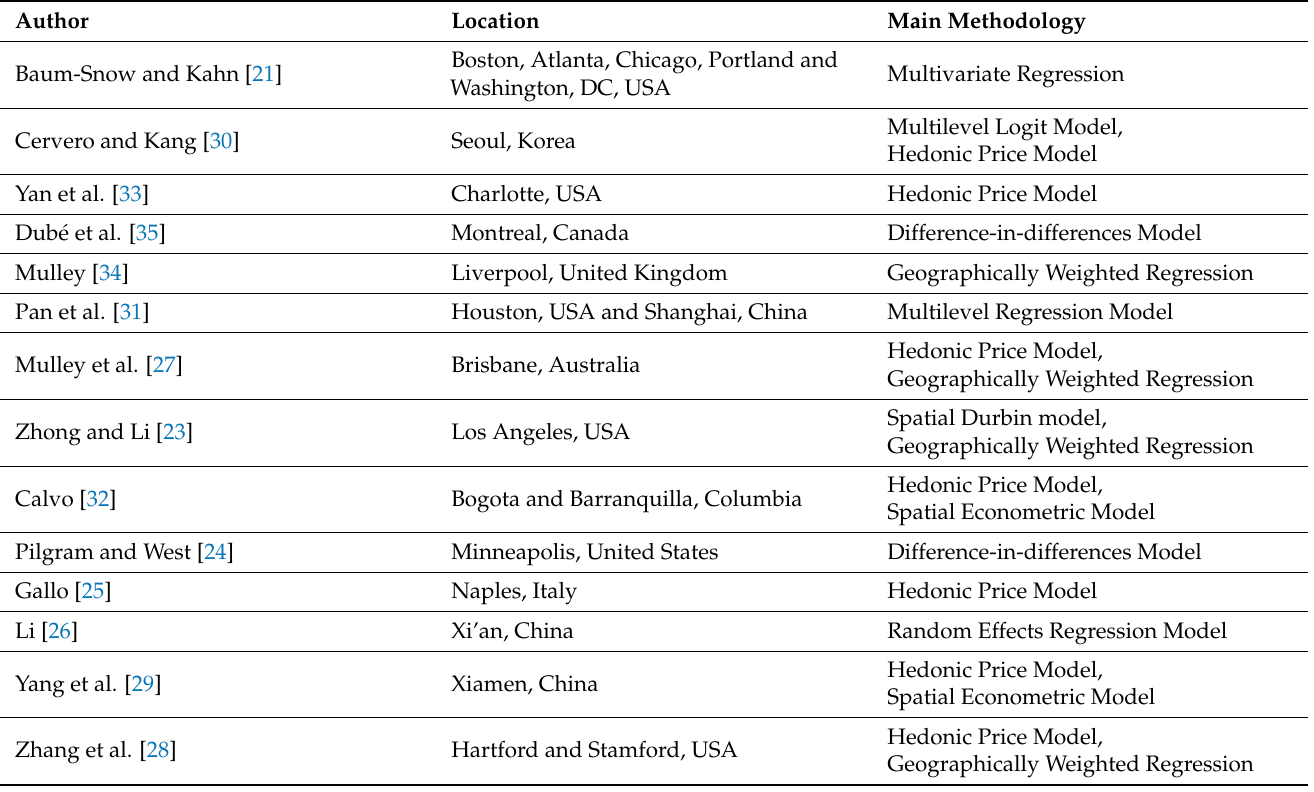
Table 2. Main methodologies applied in previous